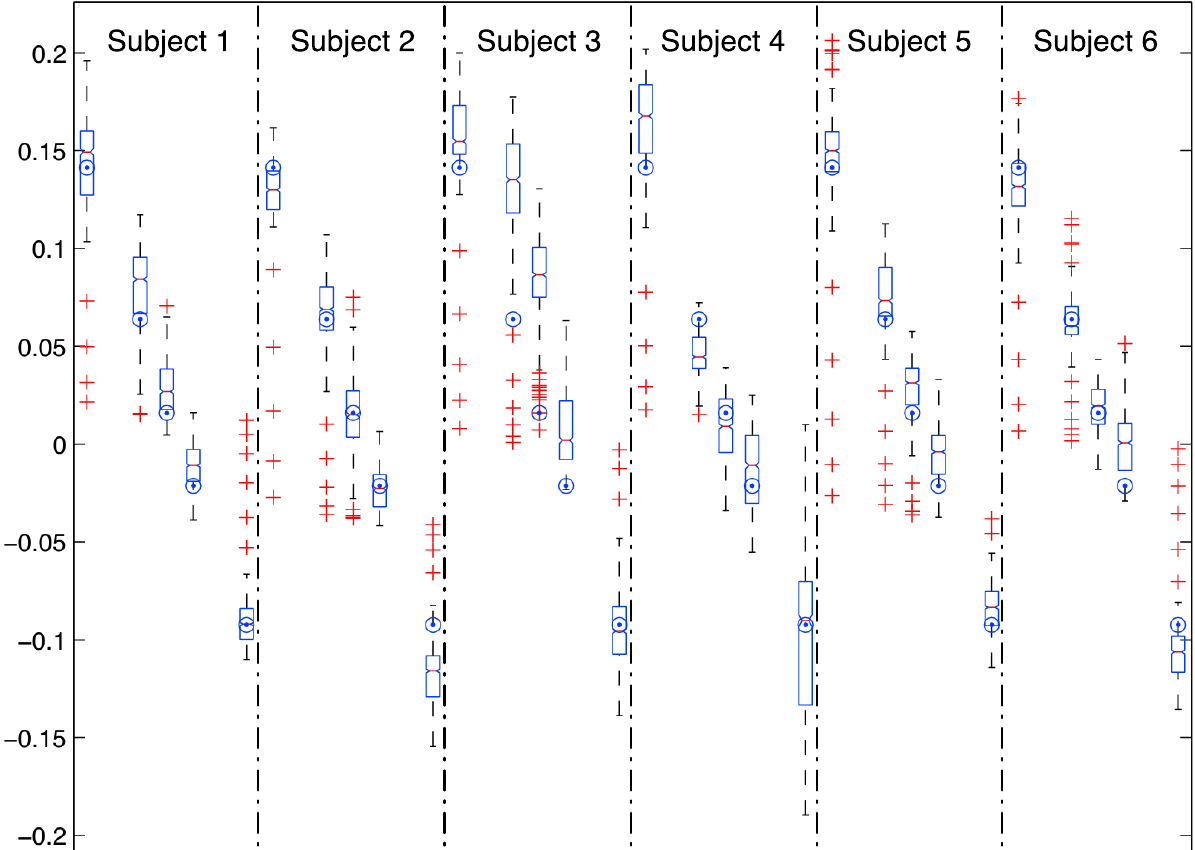
Figure 3. Corrected estimations for the six subjects at the inclinations (0.14, 0.06, 0.02, −0.02, −0.09, from left to right for each subject) using a linear model for each user defined from experiments at 0.1 and −0.05 and applying a moving average filter to raw estimations. Big dots show the actual inclination of the treadmill for each